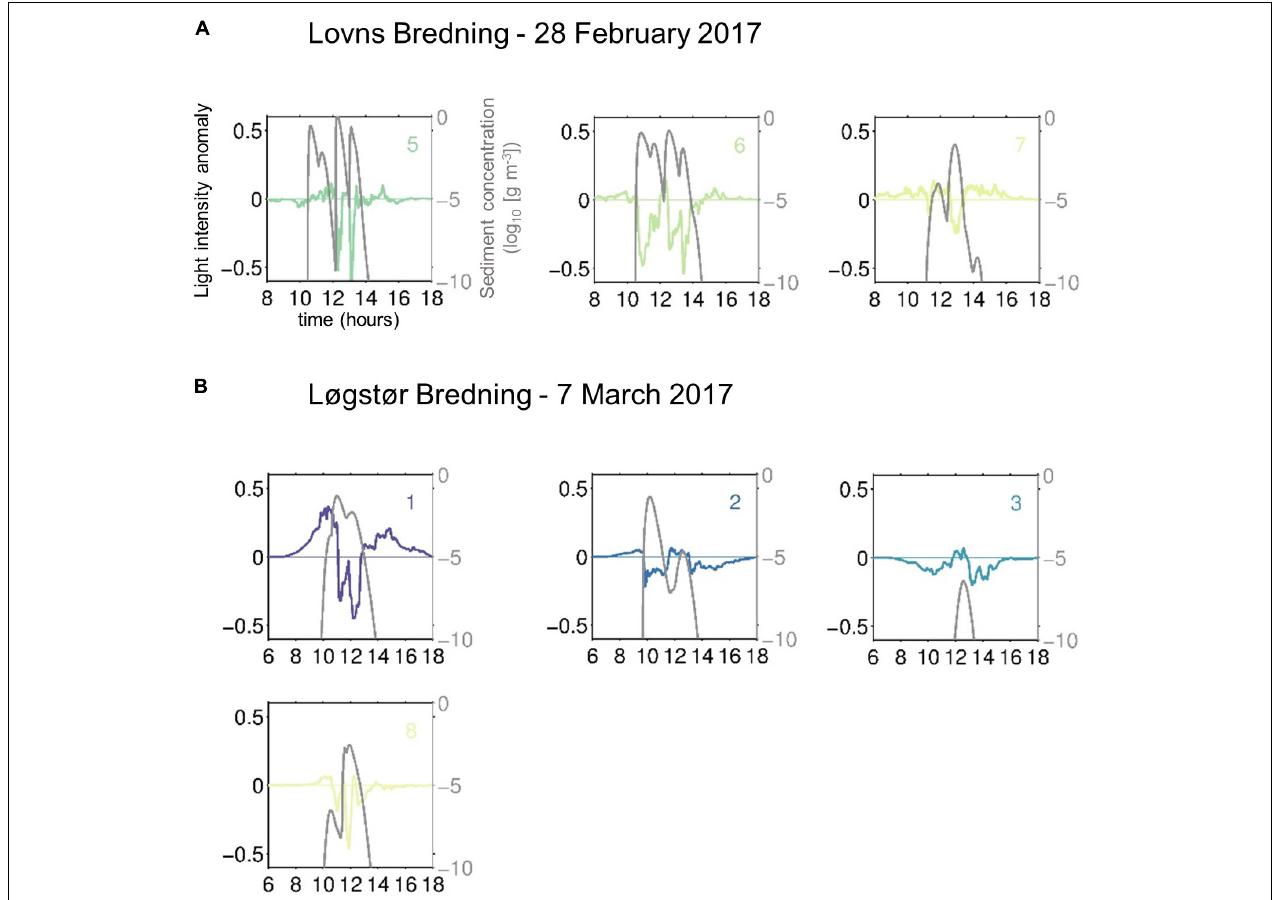
FIGURE 6 | Observed time series of light intensity anomalies at plume presence locations (colored lines, predicted by the detection threshold analysis) versus the modeled sediment concentrations (g m - 3 on log scale, gray solid lines) at 0.5 m above seabed on the first sampling day at (A) Lovns Bredning and (B) Løgstør Bredning. Colored lines and numbers refer to predicted stations as shown in Figure 4